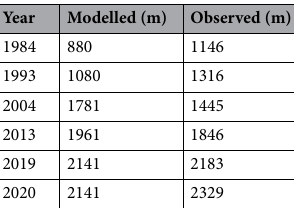
Table 2. Comparison between the modelled and observed lake